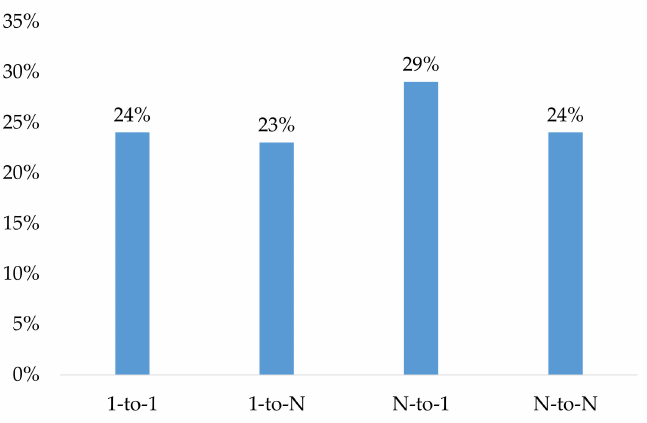
Figure 11. Type distribution of 1345 relations on